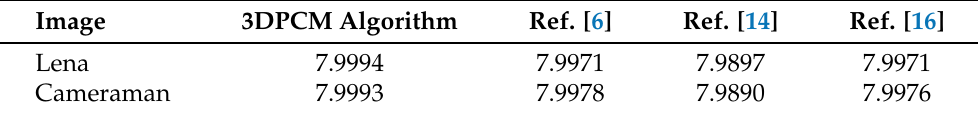
Table 4. A comparison between GE via 3DPCM algorithm and some other new